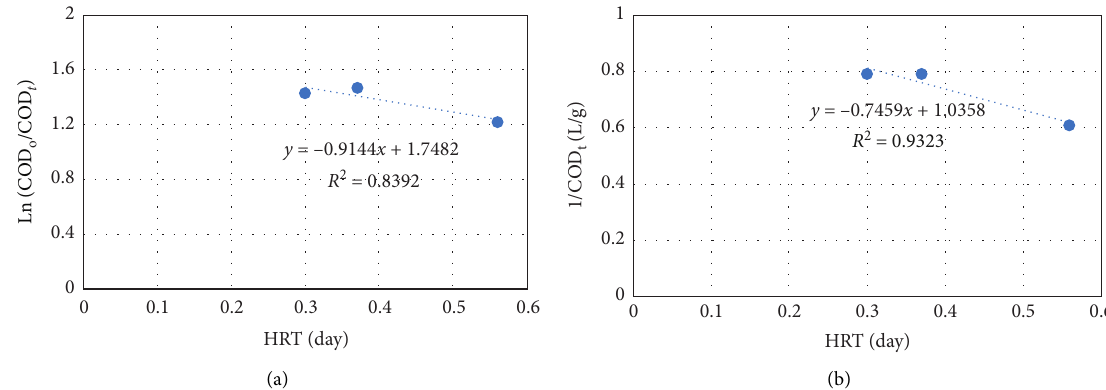
Figure 5: First-order (a) and second-order (b) kinetics of COD degradation in the pilot-scale MBBR.